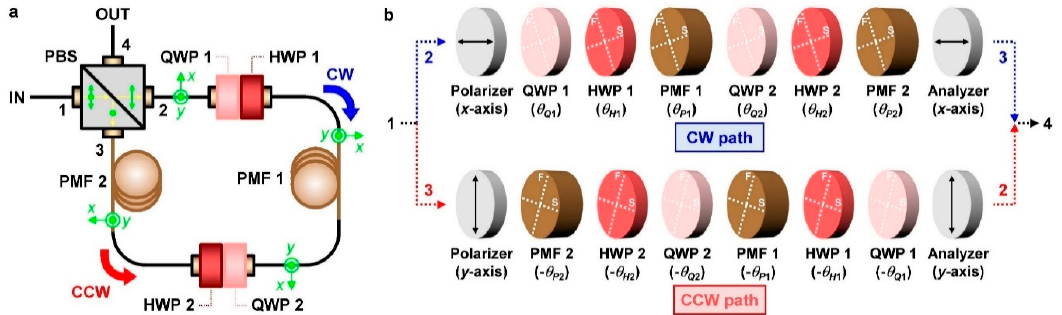
Figure 1. ( a ) Schematic diagram of the PDLS-based first-order fiber comb filter and ( b ) propagation path of light travelling through the filter.